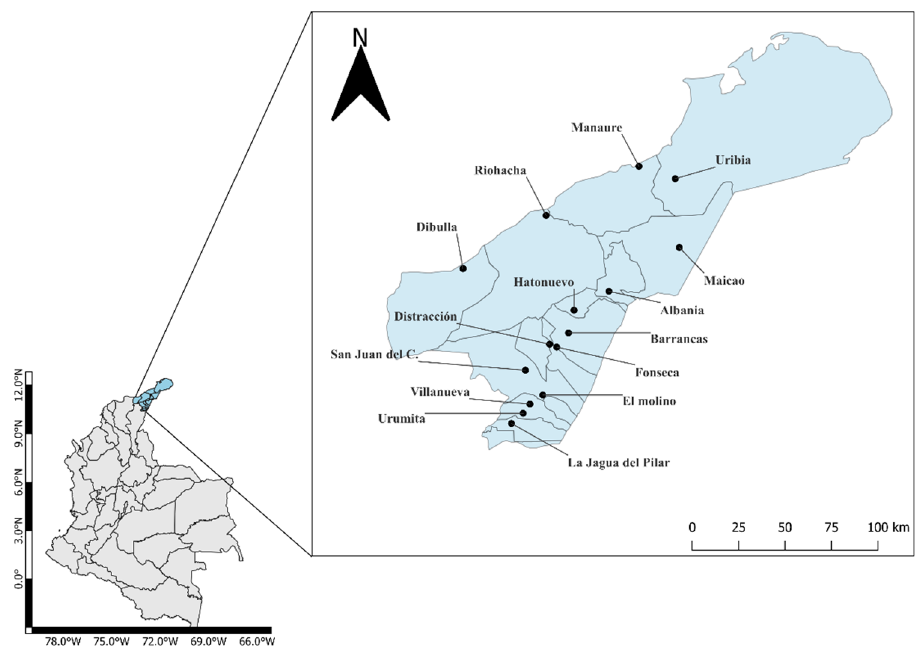
Figure 1. Aedes aegypti collection sites in the department of La Guajira, Colombia.